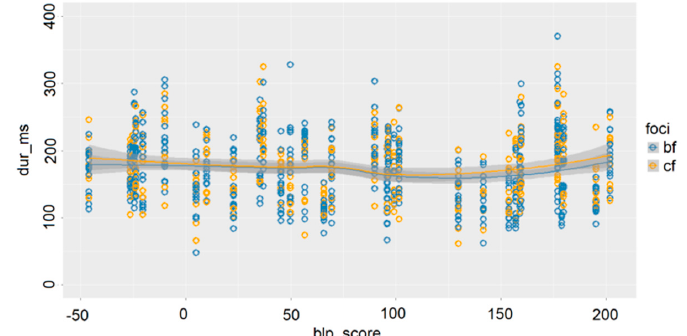
Figure 4. Duration (in ms) of the stressed syllables of the target words in subject position in broad focus (“bf”) and contrastive focus (“cf”) conditions.